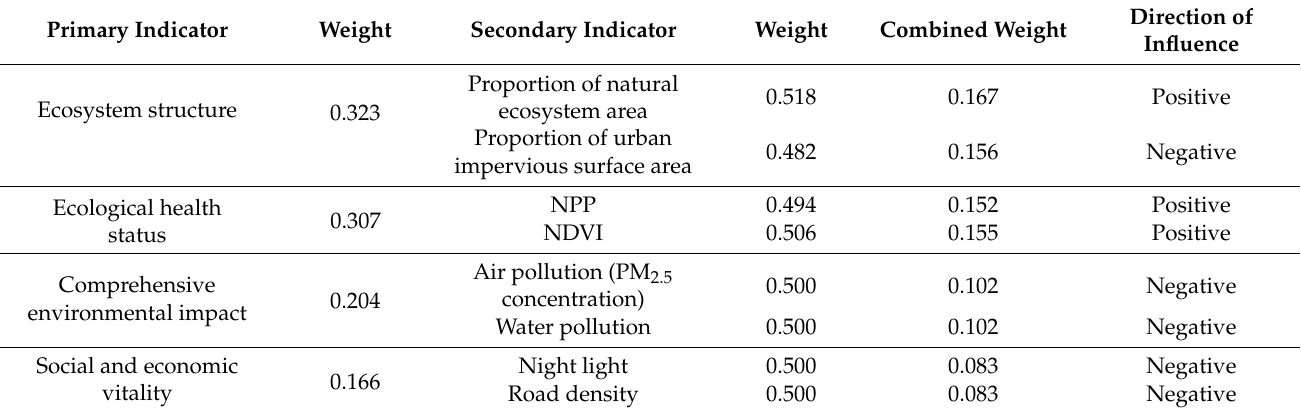
Table 3. Comprehensive evaluation index system of ecological quality in the Pan-Third Pole